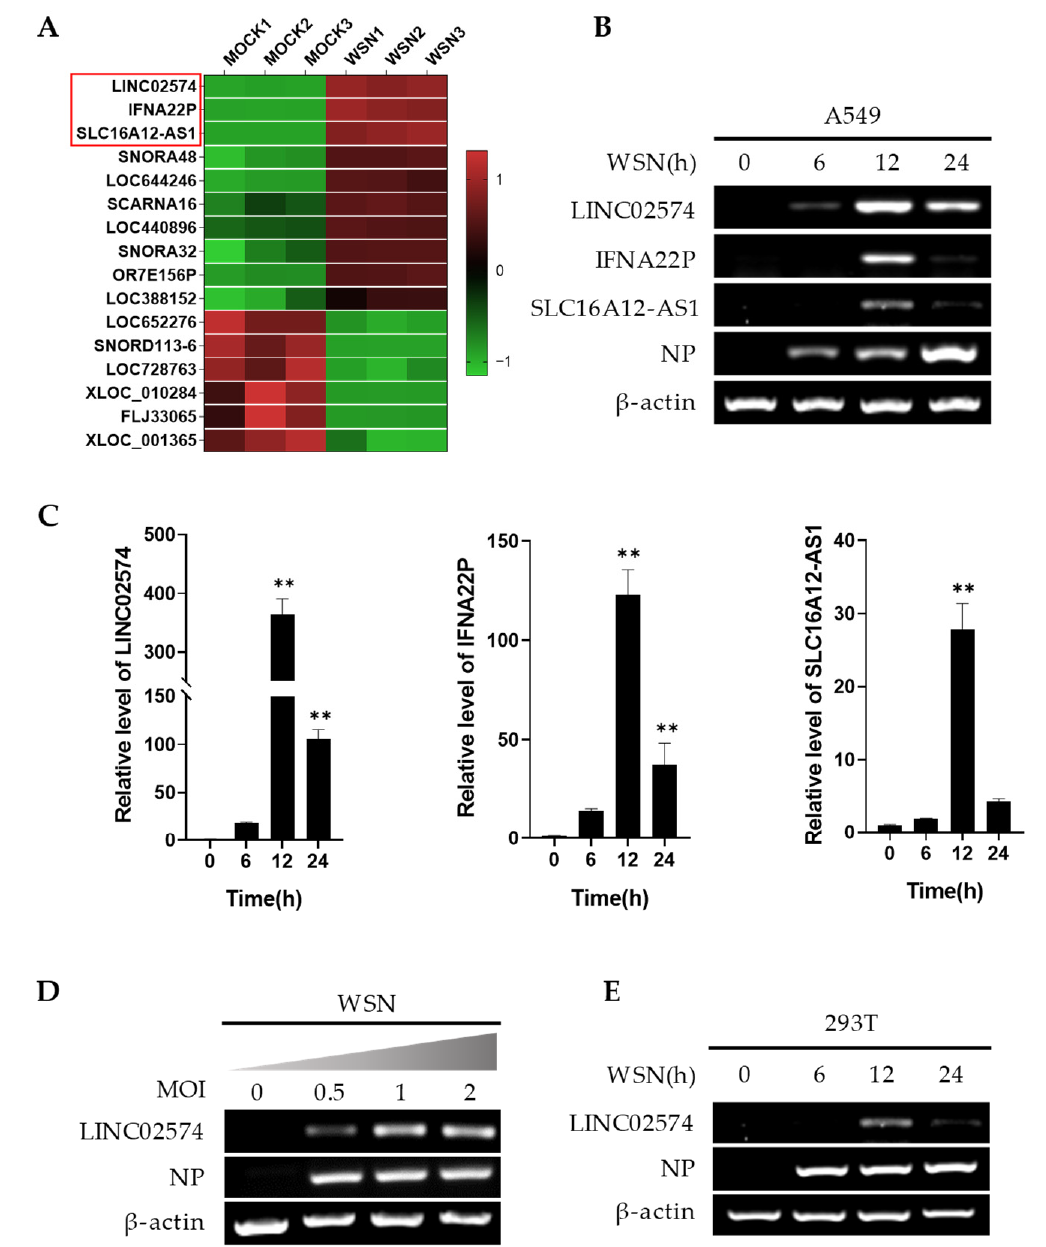
Figure 1. The expression of LINC02574 is significantly upregulated in response to IAV infection. ( A ) The differentially expressed lncRNAs in A549 cells infected with or without WSN influenza virus were analyzed by a cDNA microarray in our previous study (GEO accession no. GSE58741). Shown are representative lncRNAs whose expressions significantly changed after viral infection. Three lncRNAs with significant changes (fold change > 10) are indicated in a red rectangle. ( B , C ) Differential expressions of three selected lncRNAs in A549 cell infected with or without WSN were examined by reverse transcriptase-polymerase chain reaction (RT-PCR) and quantitative real time-polymerase chain reaction (qRT-PCR). ( D ) A549 cells were infected with different multiplicities of infection of WSN for 12 h. The expression level of LINC02574 was detected by RT-PCR. ( E ) The expression of LINC02574 in 293T cells infected with WSN was detected by RT-PCR. Data are represented as mean ± SD; n = 3; One-way analysis of variance (ANOVA) followed by LSD test: ** p < 0.01 versus time 0